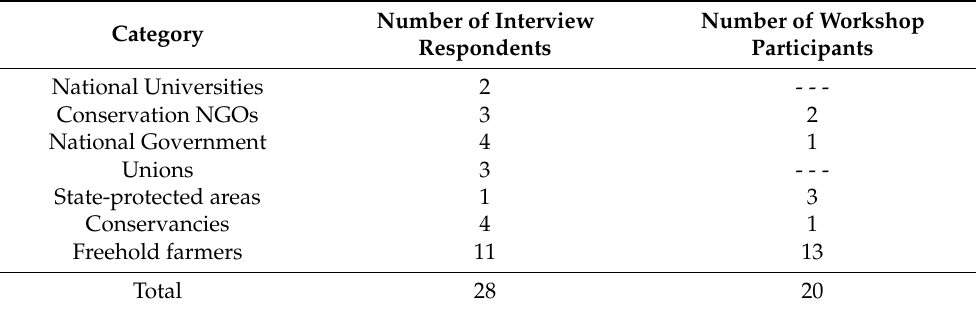
Table 1. Interview partners and participants of the stakeholder workshop. The workshop took place in Outjo, Namibia in April 2019 and the interviews followed in various locations in July 2019. Number of Interview Category